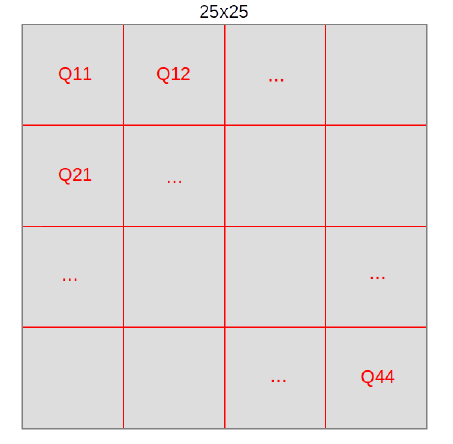
Figure 3. The division of a 25 × 25 frame in 16